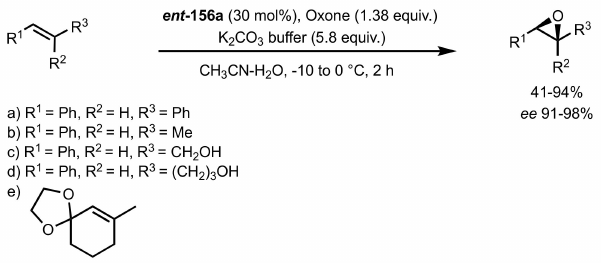
Scheme 37. The asymmetric epoxidation catalysed by ent -156a . Epoxidation of trans -enynes, -vinylesters and -vinylsilanes